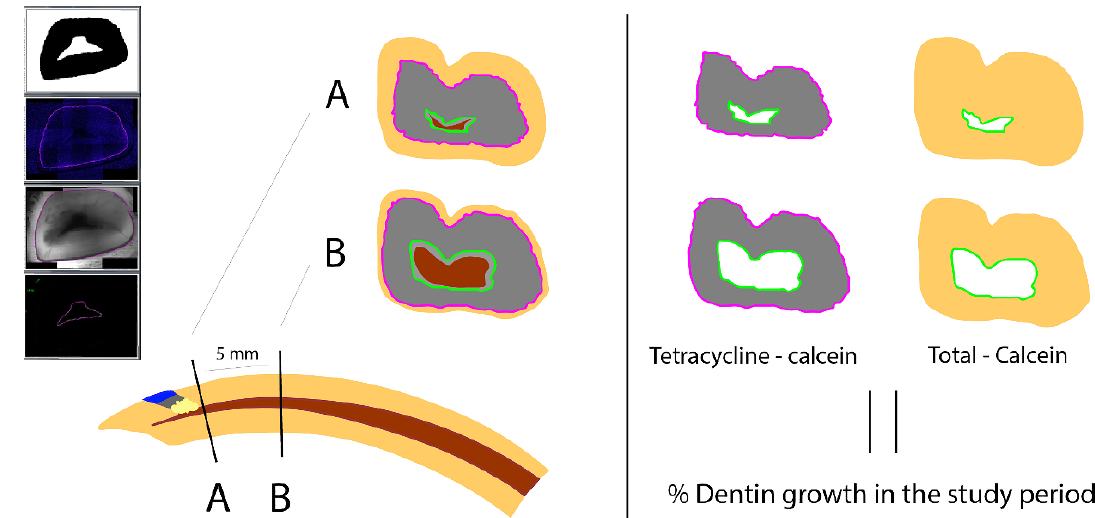
Figure 2. Illustration of the workflow of the sections’ obtention and measurements of dentinogenesis area. Two transverse cuts for each tooth: cut ( A ) 1 mm incisal to the gingival margin and cut ( B ) 5 mm apical to the first cut. Both cuts perpendicular to the curvature of the tooth. Red area: Pulp. Green line: Calcein mark. Purple line: Tetracycline mark. Gray area: Tetracycline mark–Calcein mark. Yellow area: Total mineralized area–Calcein mark. Measurements of different areas and calculation of dentin growth percentage, comparing the area between the 2 fluorescence marks (dentin growth during study time) with respect to the global area of the mineralized tooth excluding the area inside the calcein mark (total mineralized area without dentin growth after calcein application) (using the free download software ImageJ).